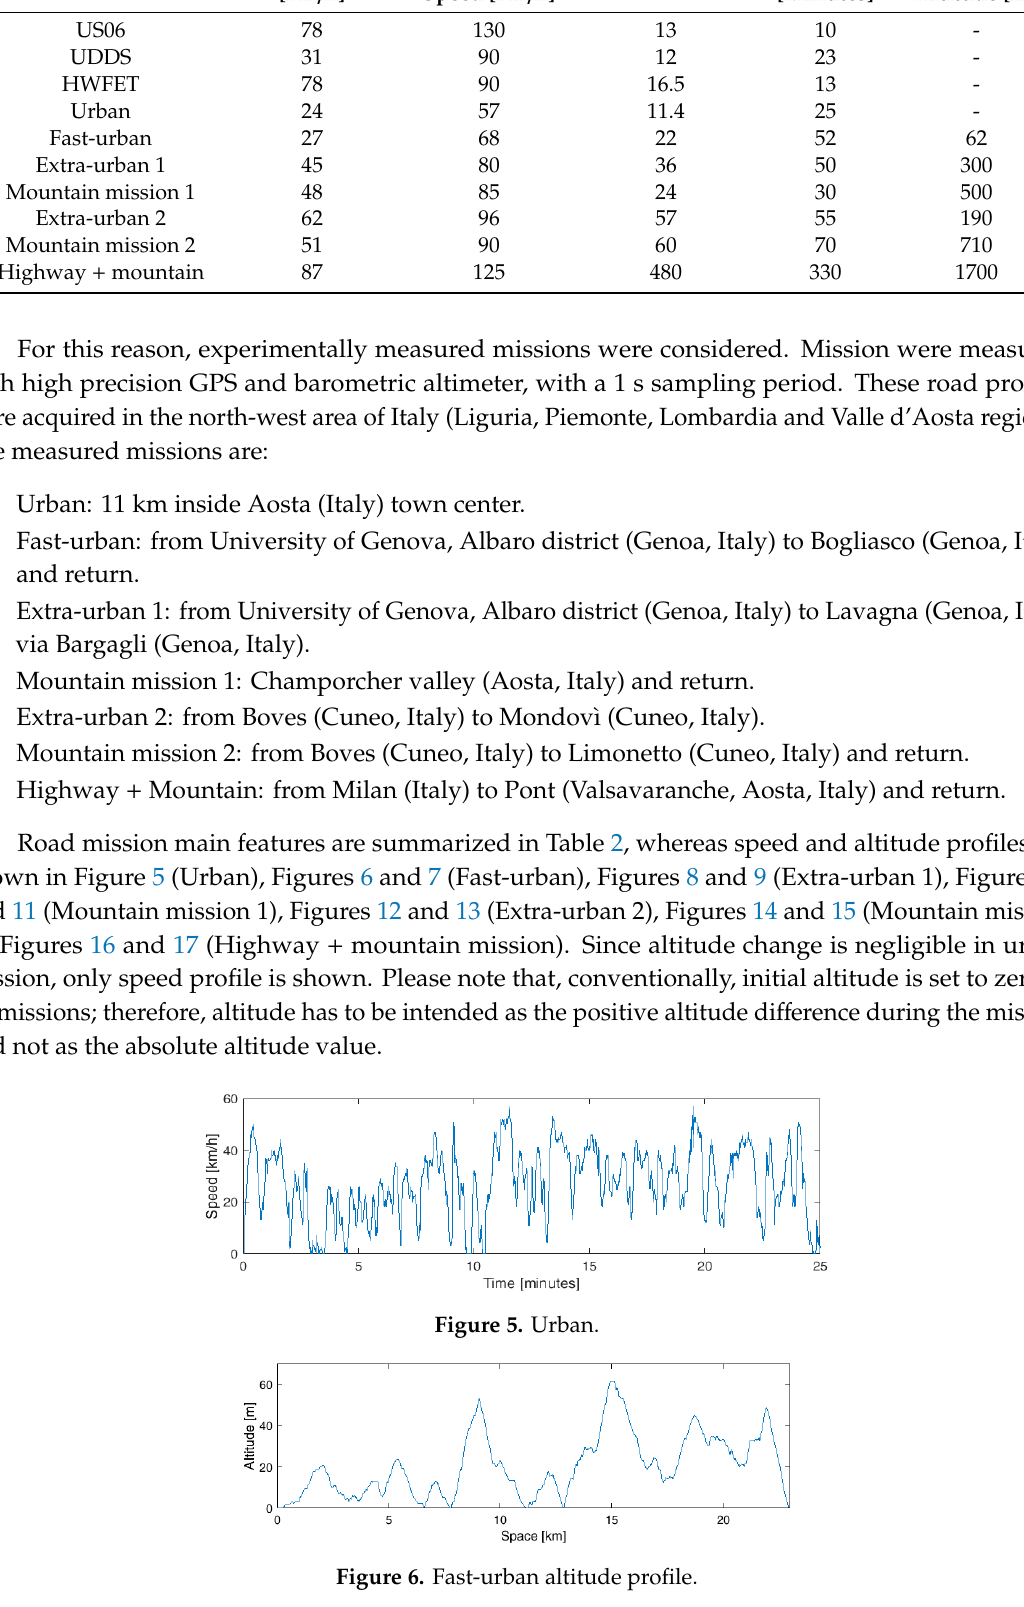
Figure 7. Fast-urban speed profile. Figure 8. Extra-urban 1 altitude profile.